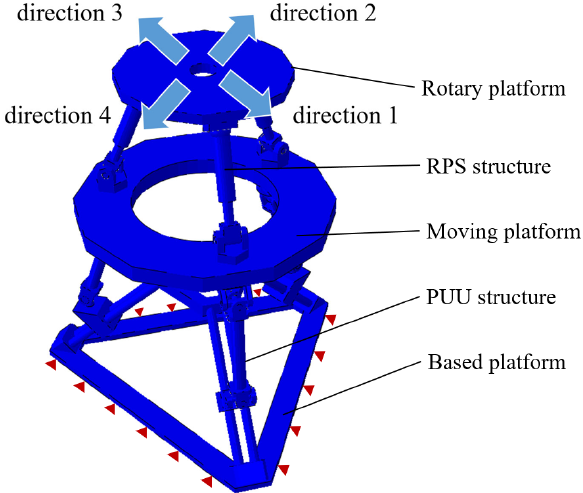
Figure 12. FE modeling of 3PUU-3PRS.